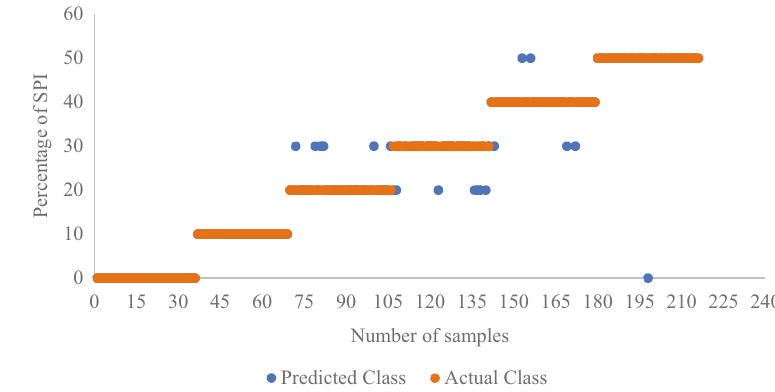
Figure 8: Scatter plot diagram of SPI added in butter fl y - pea extract powder using MSC spectra.